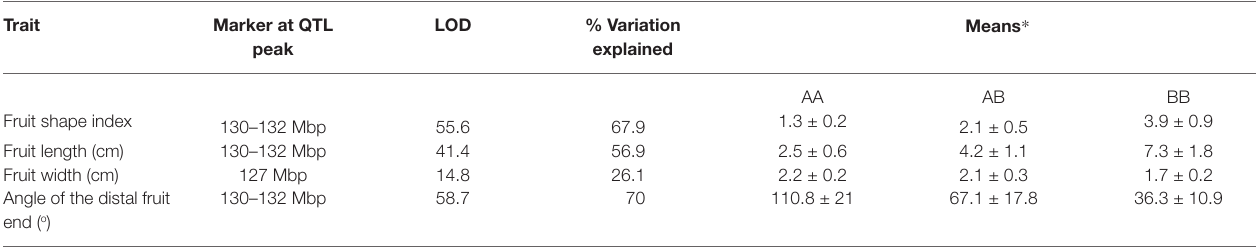
TABLE 2 | MQM mapping of fruit shape attributes in F 2 progeny of cross 5226 × 1901.